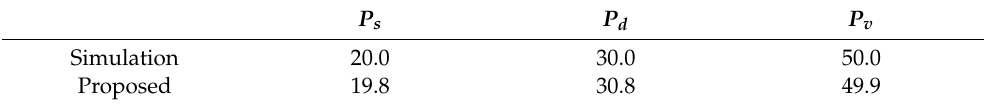
Table 6. The results of simulation data for the proposed method (%).